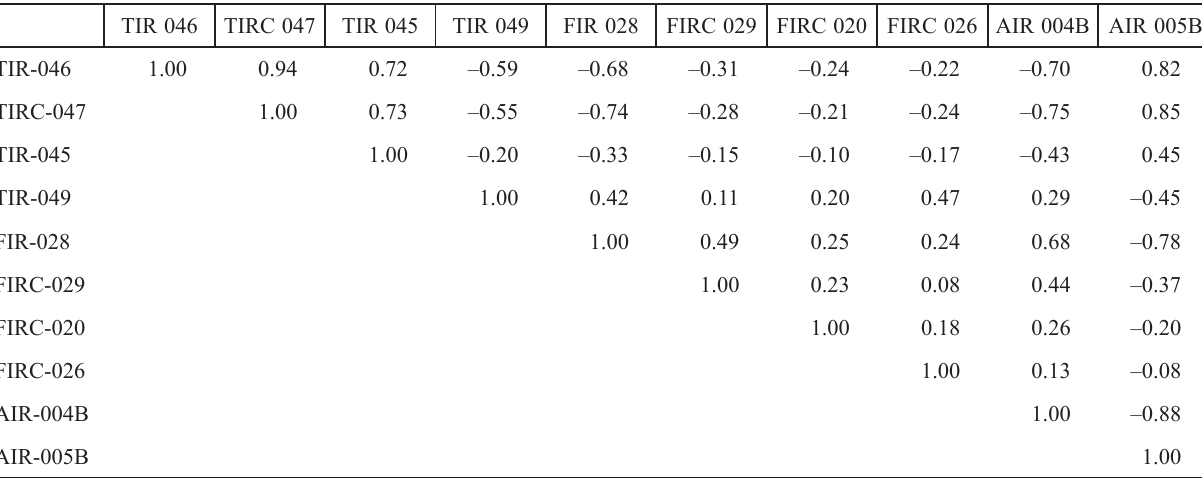
Table 5 – Correlation coefficient results within 2016 data period